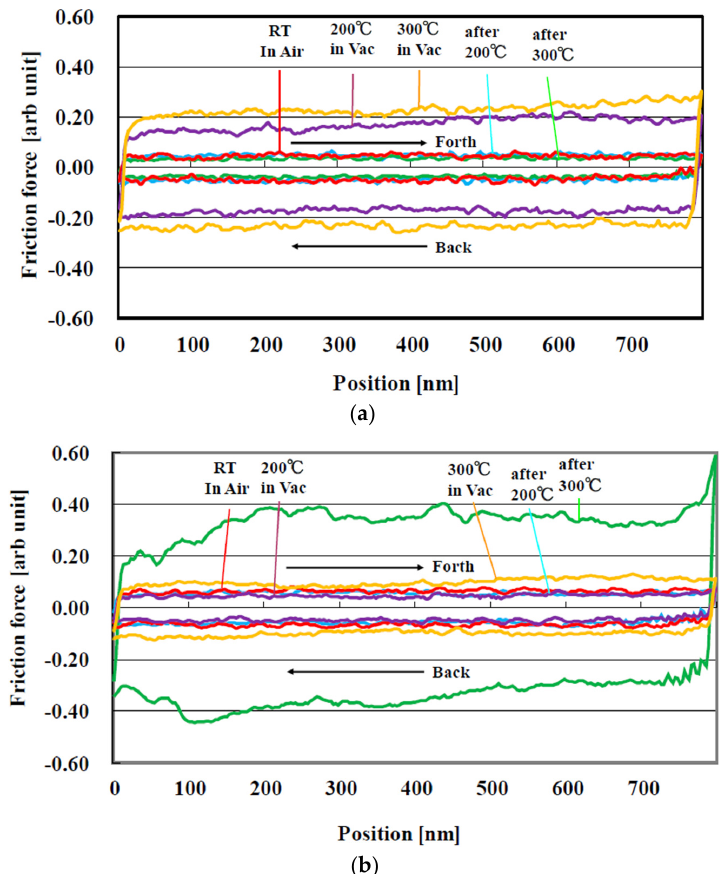
Figure 14. Friction force curve at and after RT, 200 and 300 °C. ( a ) FCVA-DLC film; ( b ) P-CVD-DLC film (Load 4500 nN).